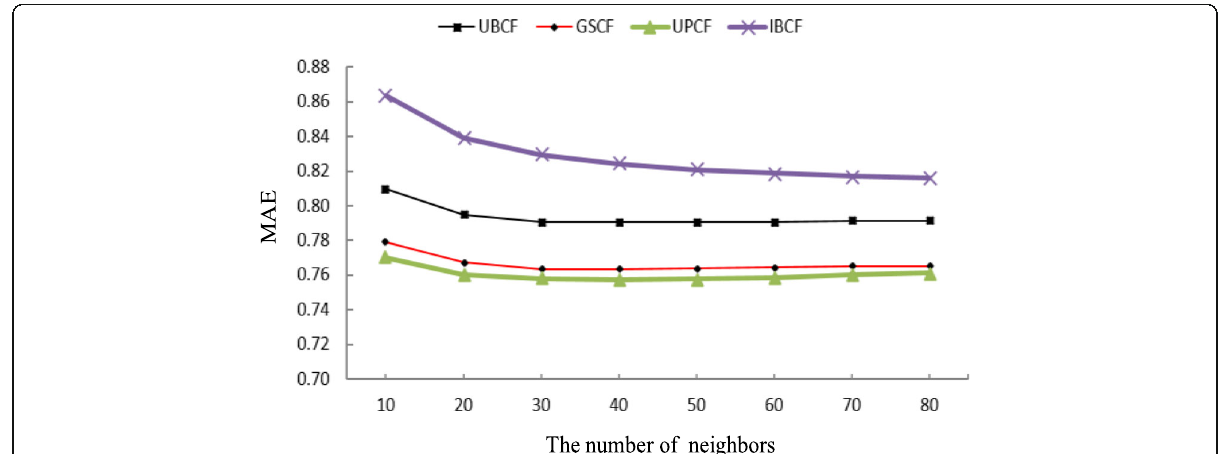
Fig. 4 Comparison of the MAE values of the four algorithms on the data set train1. When the number of neighbors is the same, the MAE value of the improved algorithm UPCF is the smallest, that is, the prediction error is the smallest and the recommendation performance is the best. When the number of neighbors is different, the MAE value of the four algorithms decreases first and then increases with the growth of the neighbors. It shows that the MAE is affected by the neighbors, in other words, the performance is affected by the